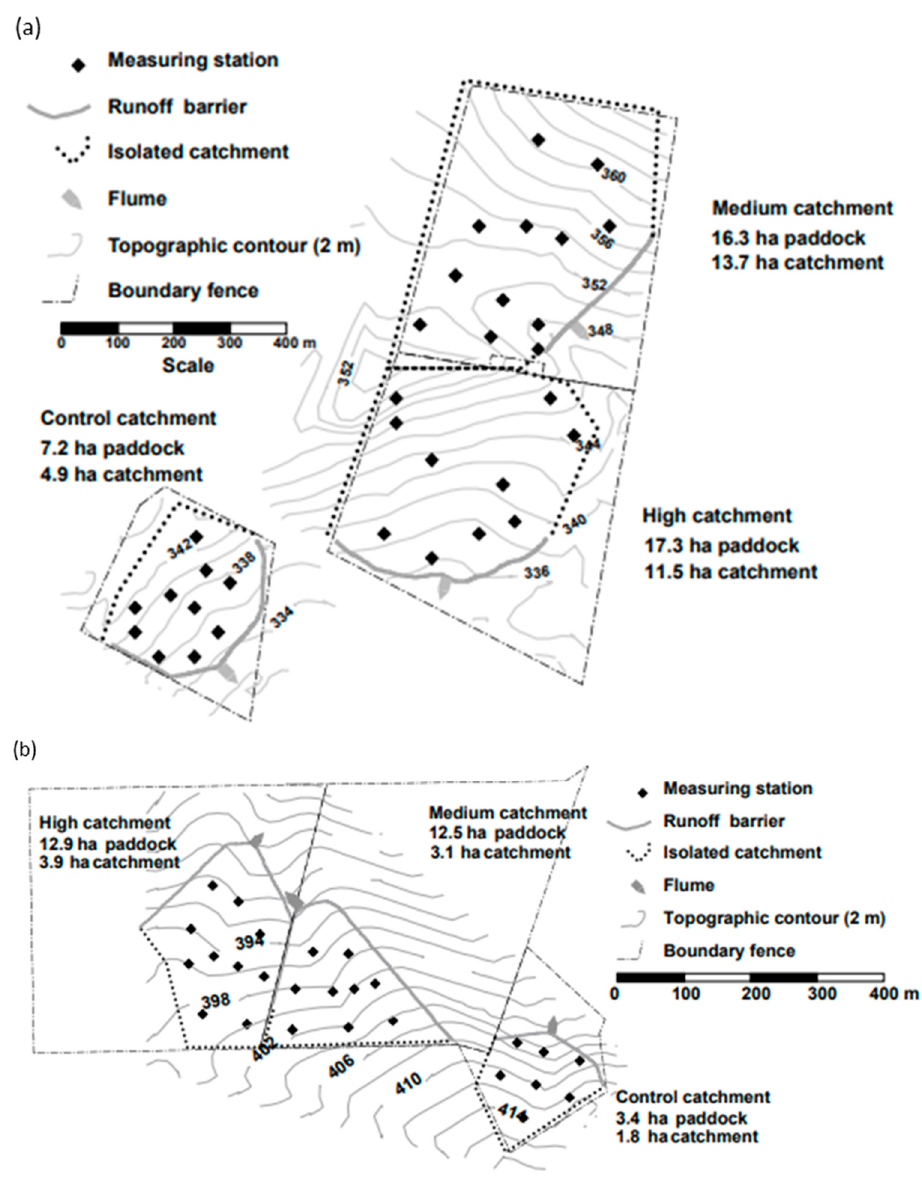
Figure 1. The design of the field experiments at Maindample ( a ) and Ruffy ( b ) showing the three treatments at each location—Control (Low), Medium and High. Reproduced with permission from [24].